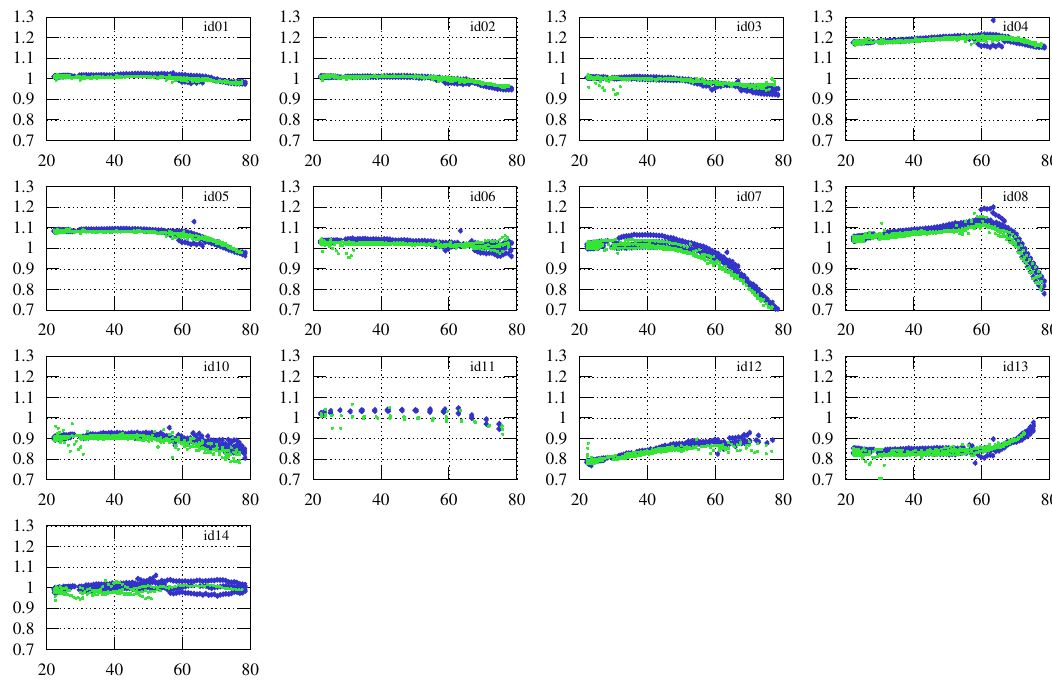
Fig. 7. Ratios between clear-sky UV Index measurements with user instruments and the reference (vertical axis) against the solar zenith angle (horizontal axis). Morning (blue) and afternoon (green) measurements are plotted separately.